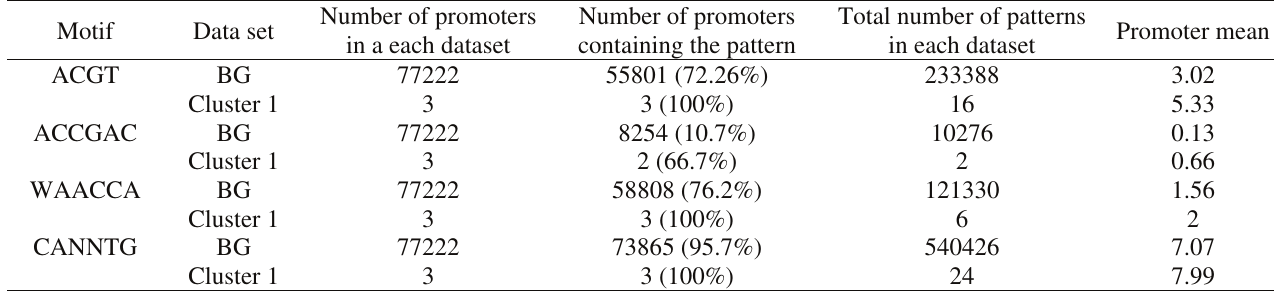
Table S2 – Frequency of cis elements present in promoters of the